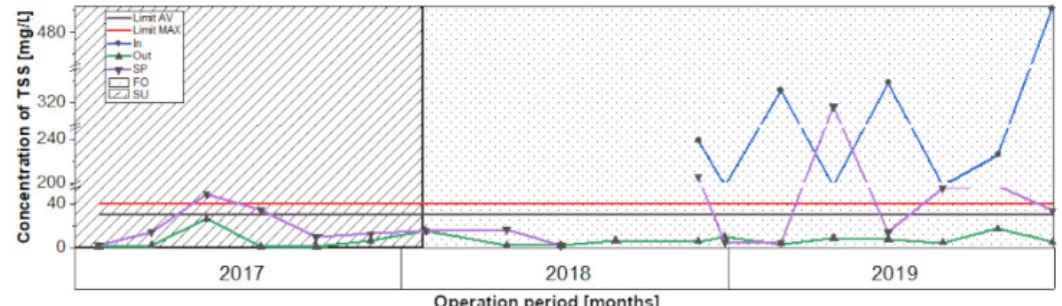
Figure 6. TSS concentration development. AV = average limit, MAX = maximal limit, In = inlet, Out = outlet, SP = stabilization pond, FO = full operation, SU = start-up phase.